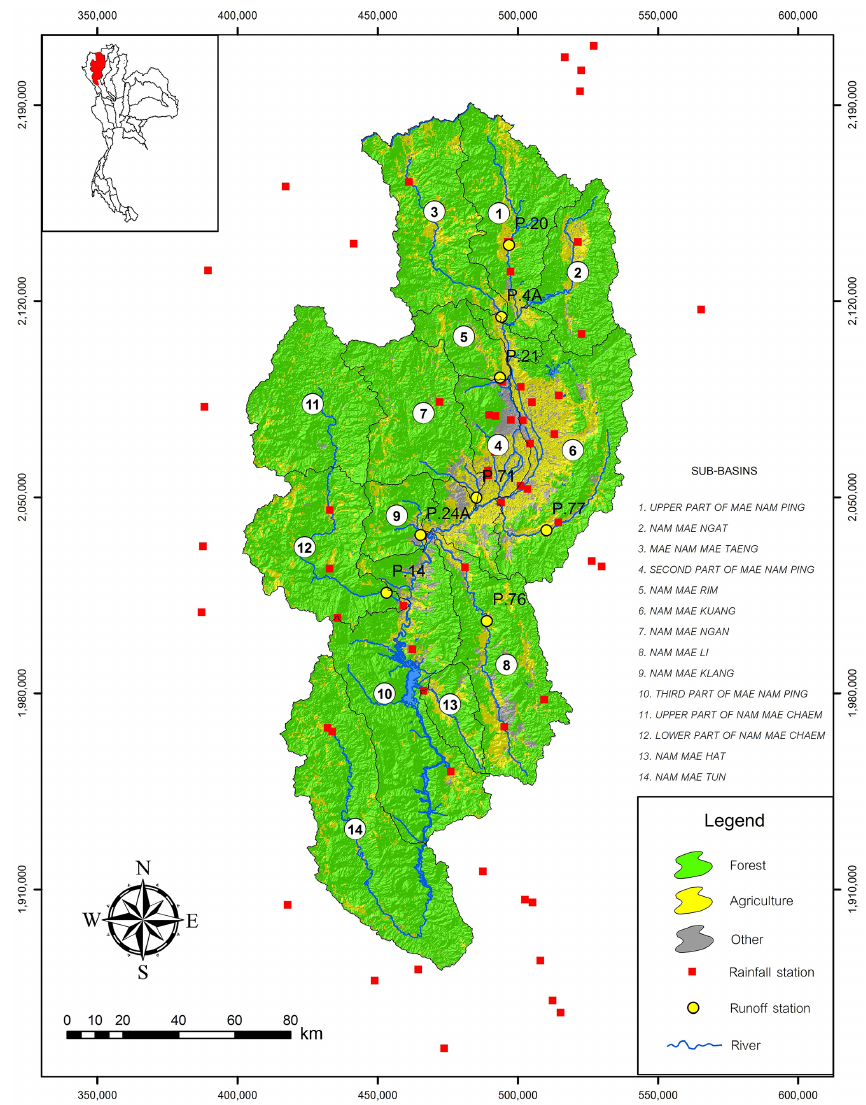
Figure 1. The UPRB and the locations of the rain-gauge and runoff stations. The numbers indicate the 14 sub-basins of the